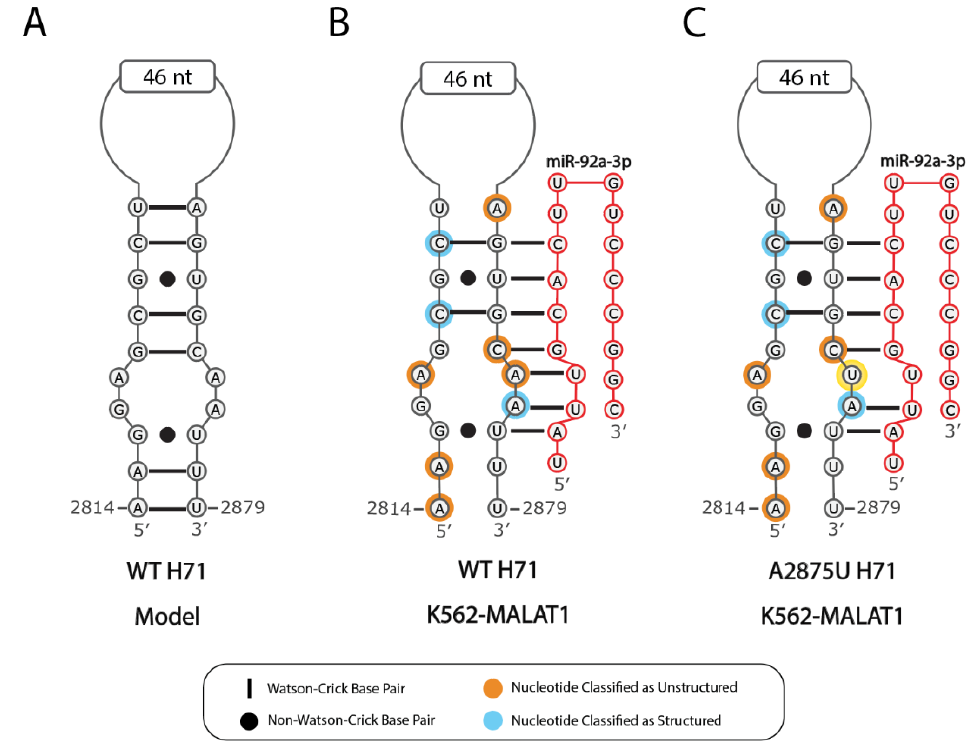
Figure 5. A2875U disrupts the miR-92-3p binding site on H71. ( A ) A schematic is shown for the predicted structure of wild type (WT) H71 in noncancerous cells [15]. Nucleotides with an orange background are classified as unstructured and nucleotides with a blue background are classified as structured. The expected binding of miR-92a-3p (red) to H71 in K562-MALAT1 is shown for ( B ) wild type H71 and ( C ) H71 with the A2875U mutation, which is outlined in yellow. The same disruption to seed binding is expected for miR-363-3p and miR-25-3p (Supplemental Table S1, “Seq-Markup” tab).